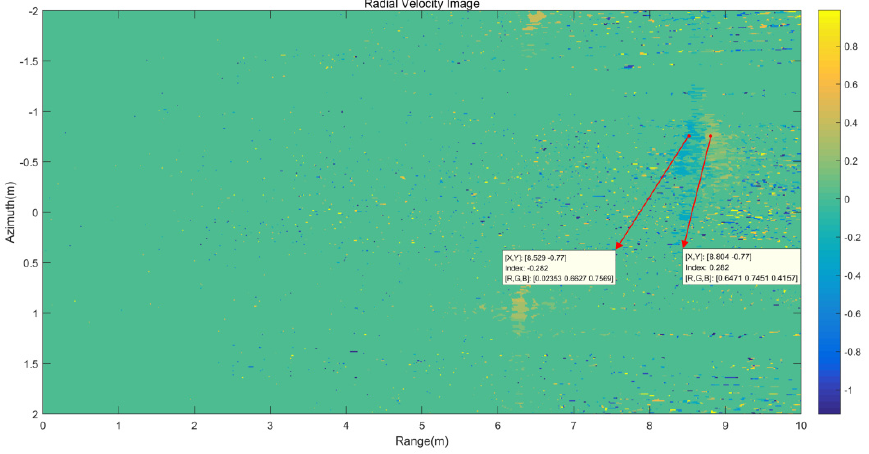
Figure 11. Kelvin wake radial velocity image.